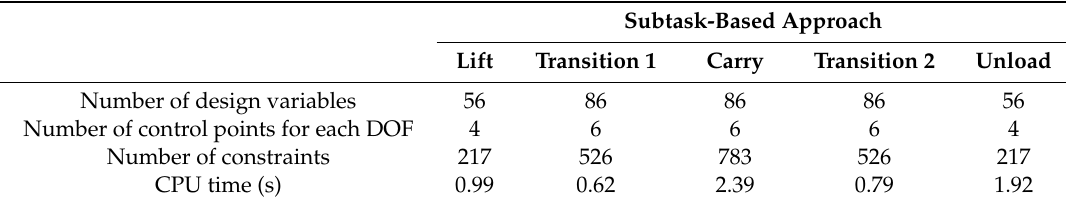
Table 2. Optimization information for subtask-based approach.